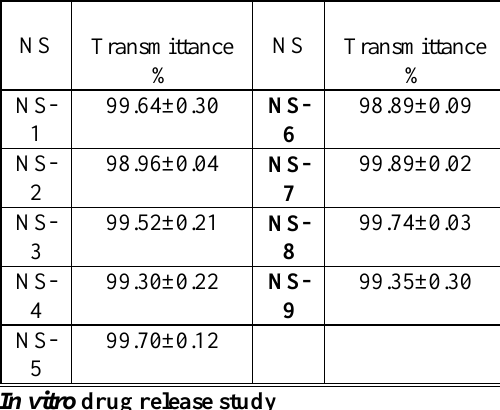
8. Transmittance percent measurement of LZL-NS formulations; (Mean±SD); n=3.